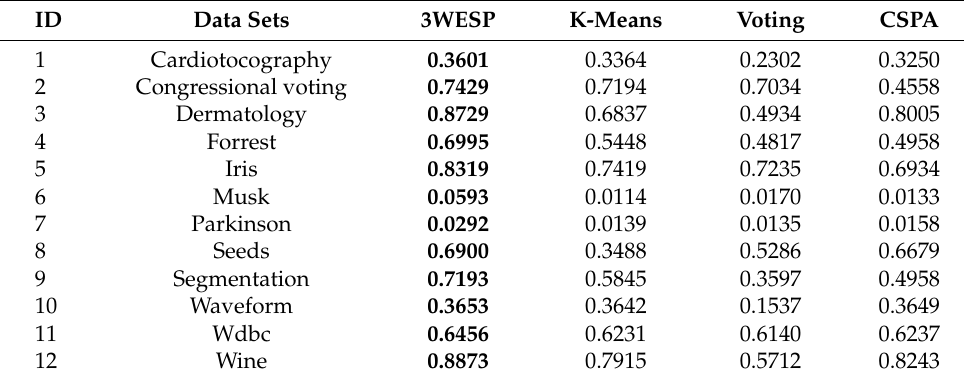
Table 4. Experimental results of NMI on UCI data sets.